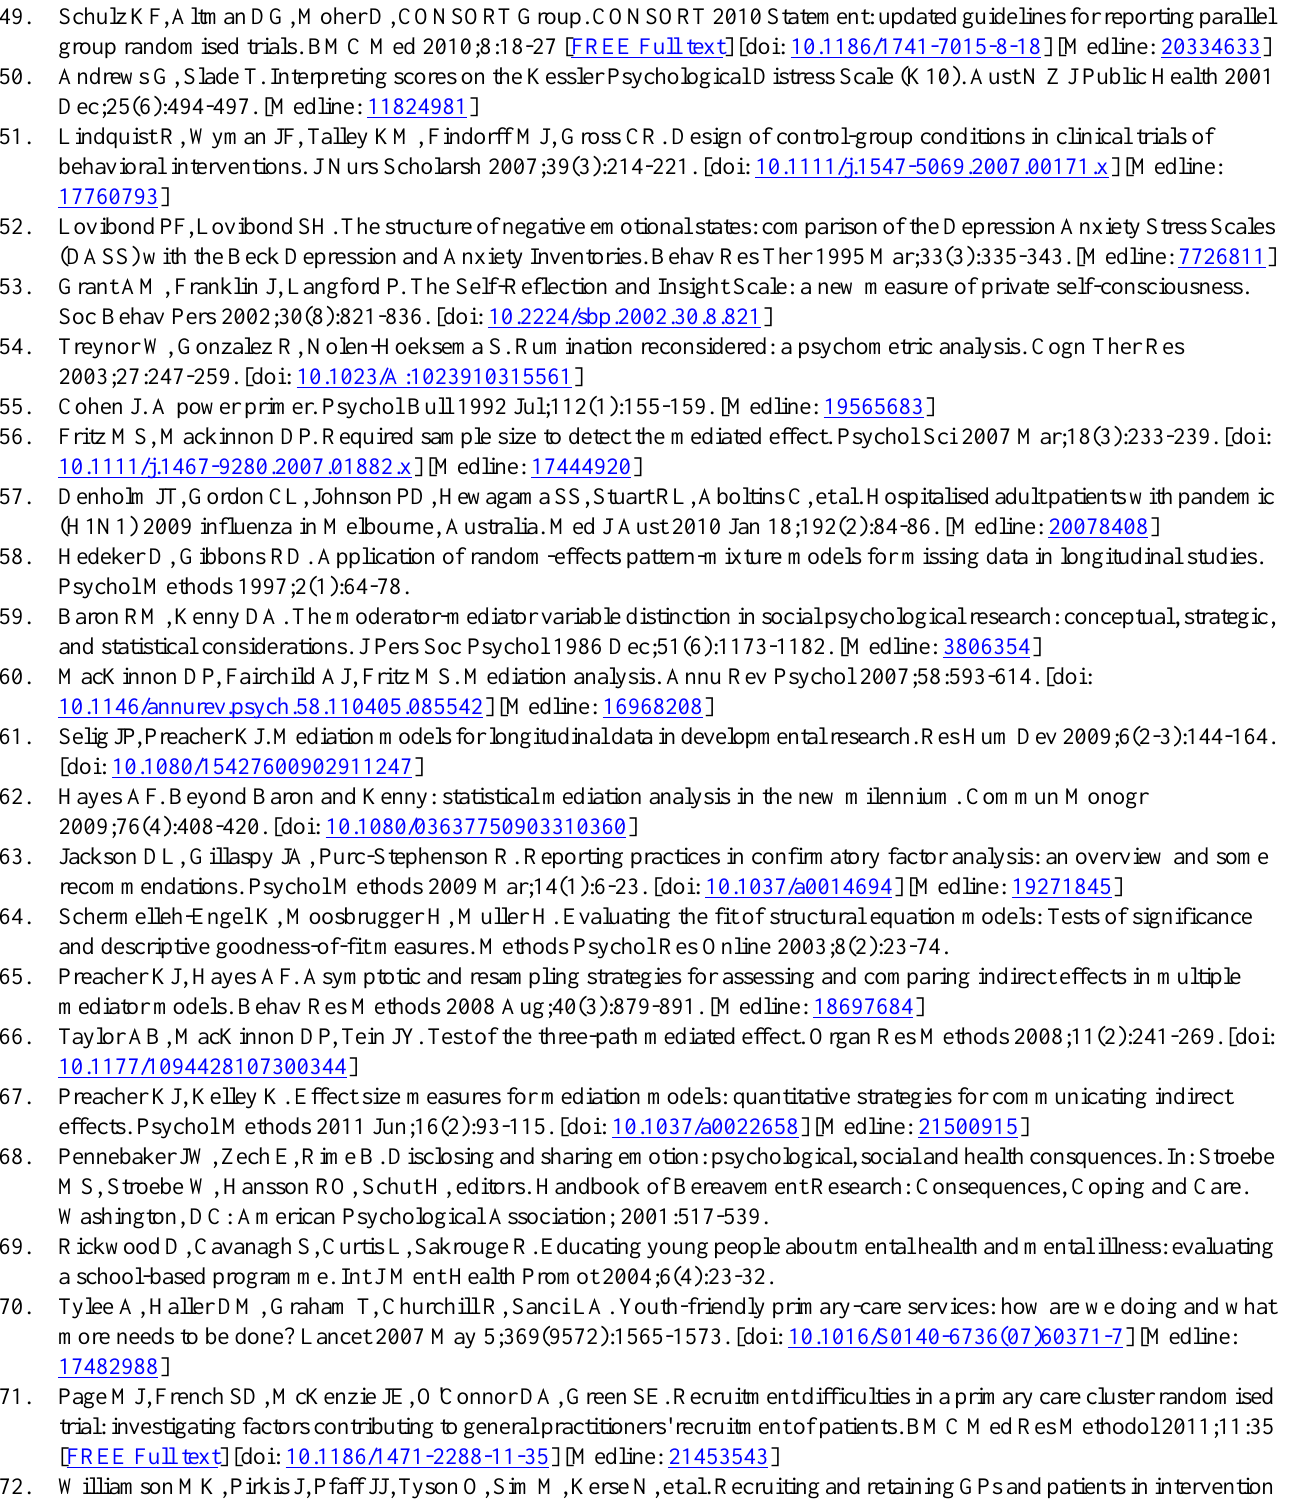
Abbreviations DASS: Depression Anxiety Stress Scale ESA: emotional self-awareness GP: general practitioner LGCM: latent growth curve